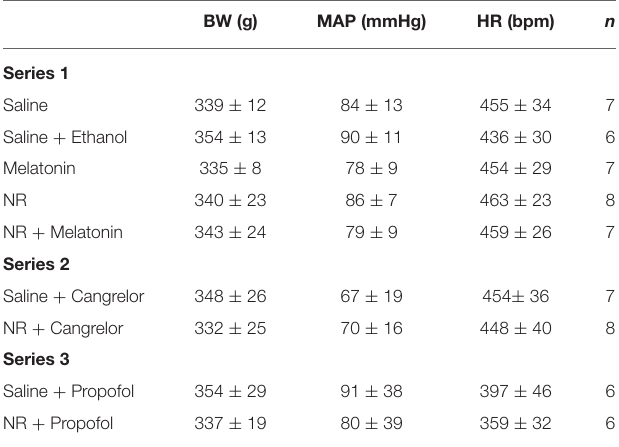
TABLE 1 | Baseline characteristics of the rats in all